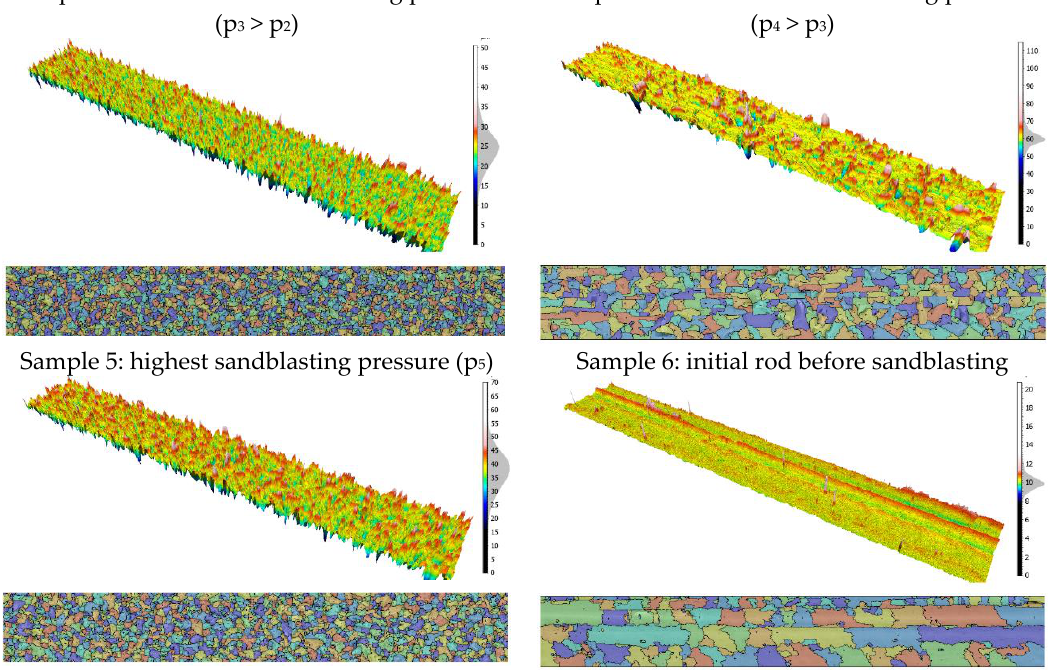
Figure 3. Three-dimensional topography and motif maps with histograms of the height amplitudes (in µm) corresponding of the six process configurations.